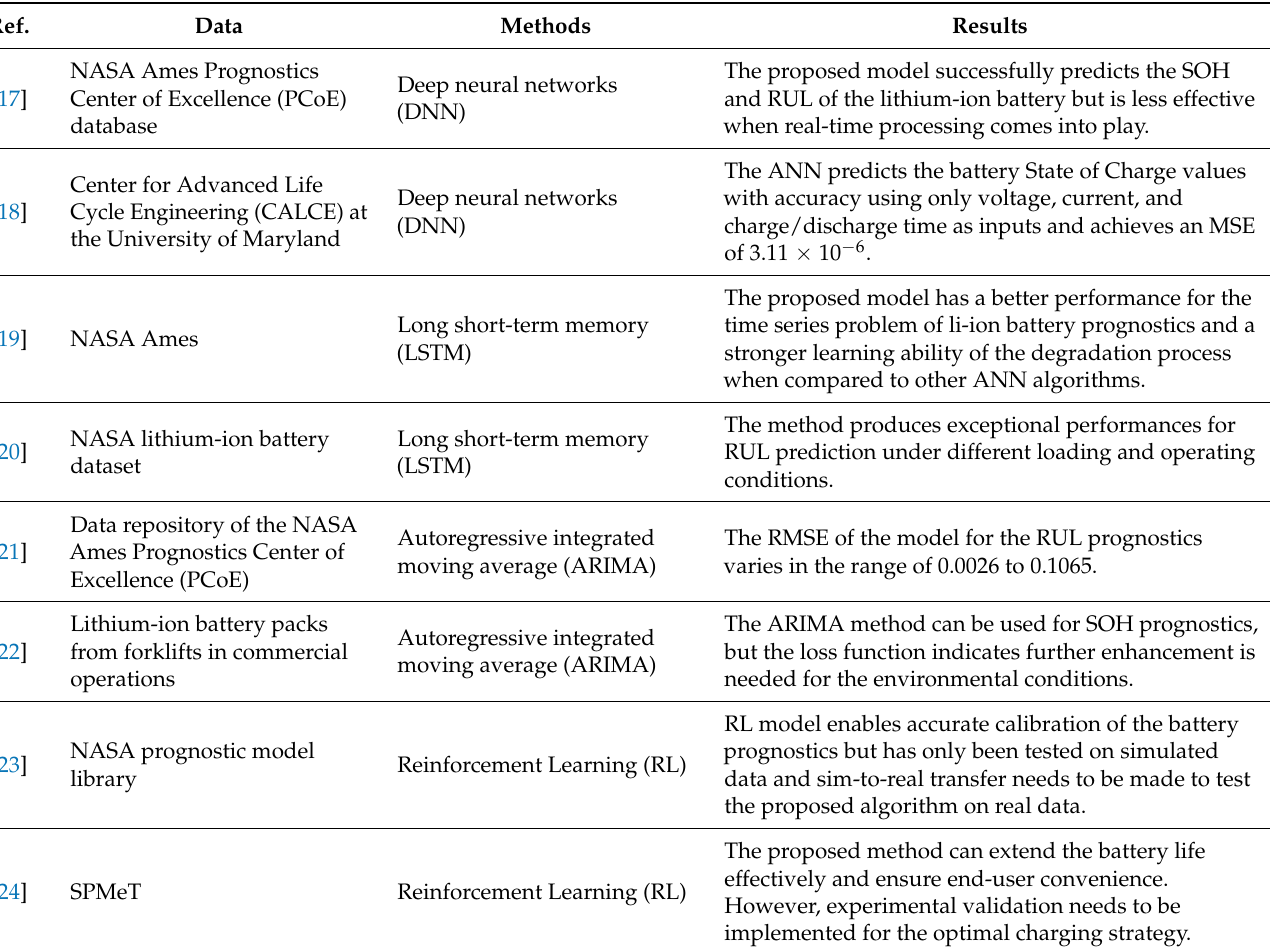
Table 1. An overview of different approaches to lithium-ion battery